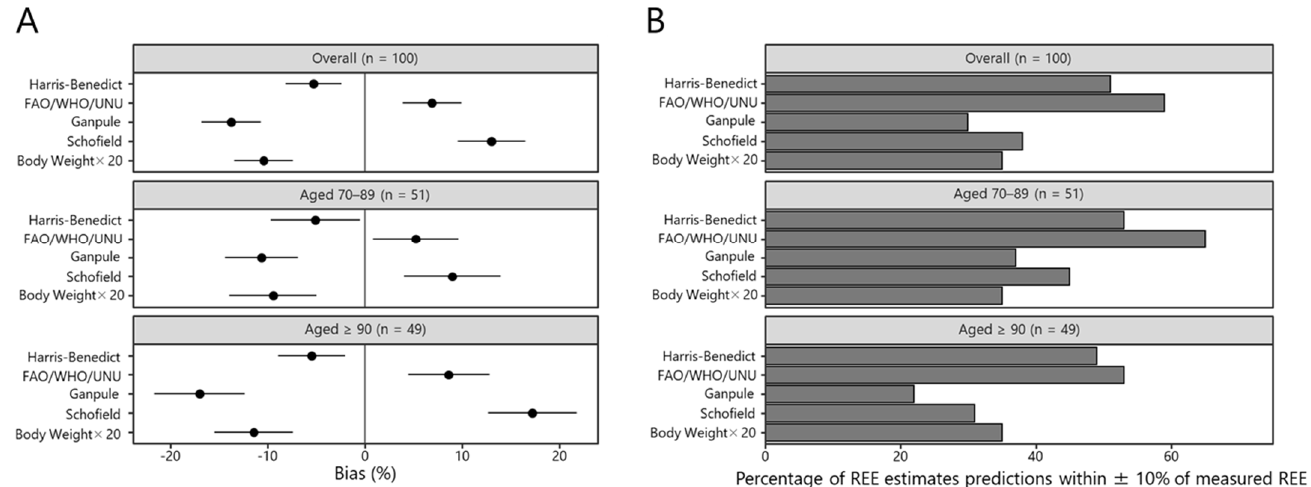
Figure 1. Accuracy of resting energy expenditure (REE) prediction equations by age group. ( A ) Per- cent bias of resting energy expenditure (REE) prediction equations compared to the measured REE. The mean relative bias (%) was calculated as follows: (( Δ REE Predicted )/REE Measured ) × 100. Error bars represent the 95% confidence interval; ( B ) Percentage of REE predictions with a mean relative bias (%) within 10% of the measured REE for each prediction equation.